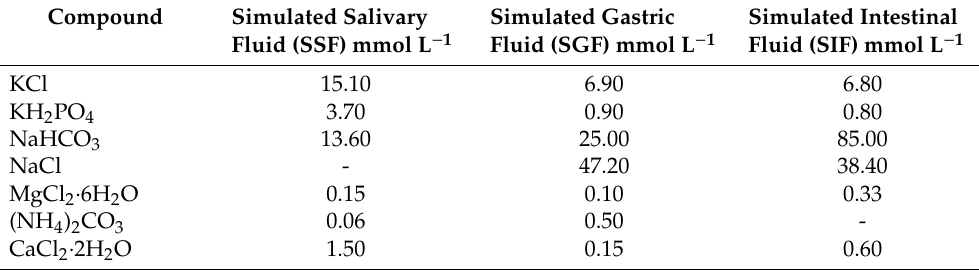
Table 3. Composition of simulated salivary, gastric and intestinal electrolytes